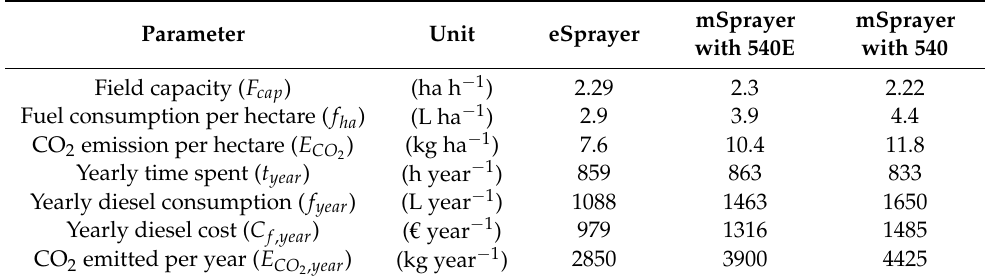
Table 13. Operational and environmental indexes with fan speed ( n f ) set at 1300 rpm. These results were calculated supposing a field area to work equal to 375